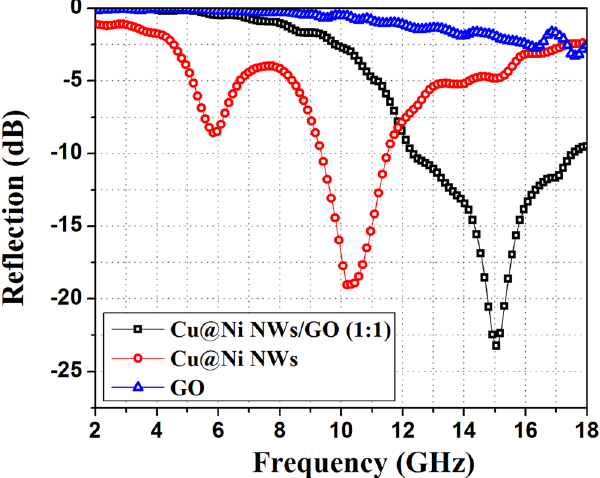
Figure 5. The RL curves of the Cu@Ni NWs/GO (1:1), Cu@Ni NWs, and GO samples in paraffin matrix with thickness of 2.5 mm in the frequency range of 2.0–18.0